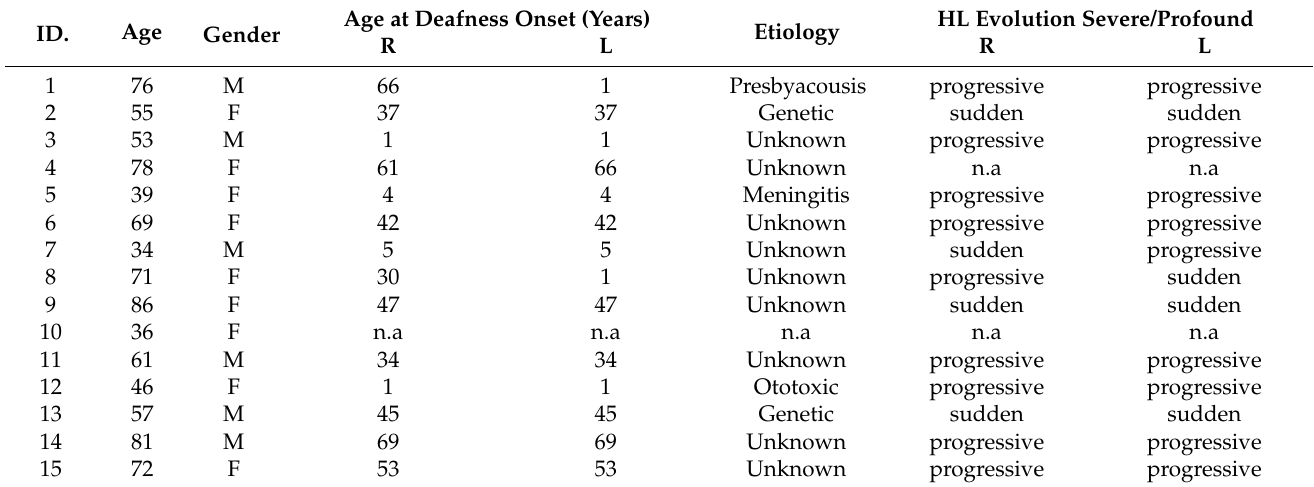
Table 1. Demographic characterization of all included participants. ( n =